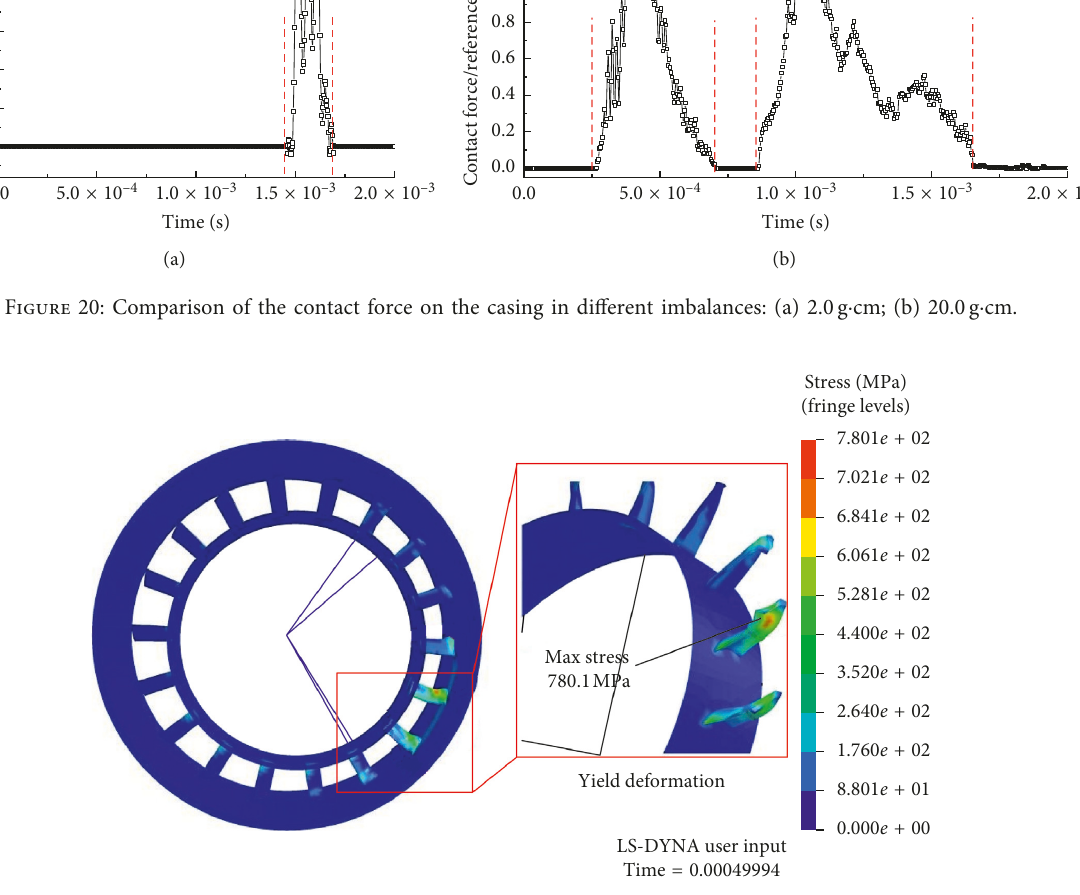
Figure 21: Distribution of Von Mises stress with lower yield strength.